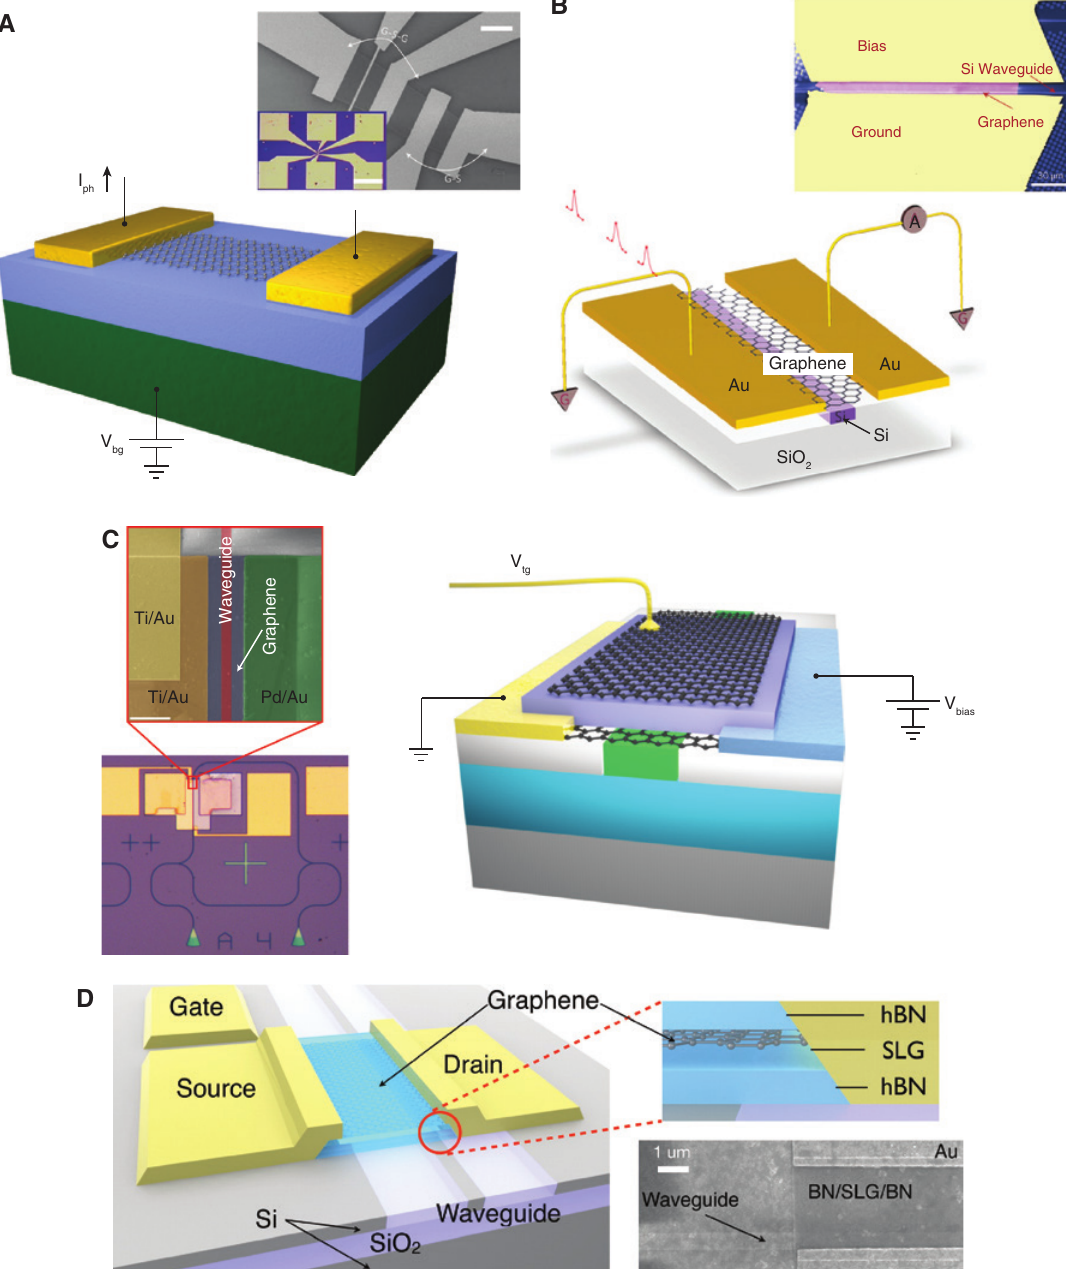
Figure 2: Graphene